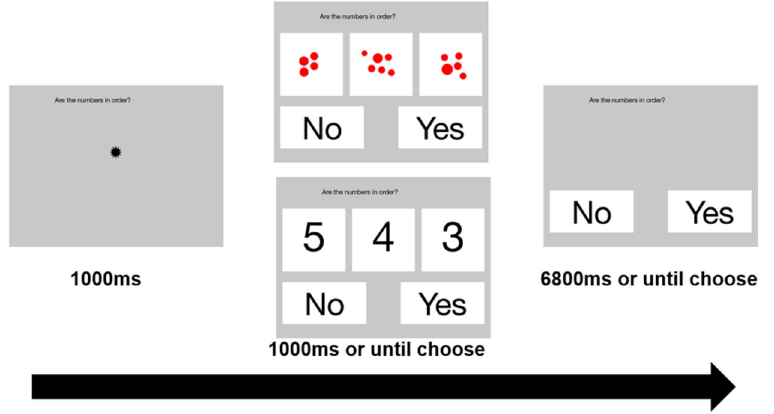
Figure 1. Example of a symbolic and a non-symbolic trial of the numeric ordering